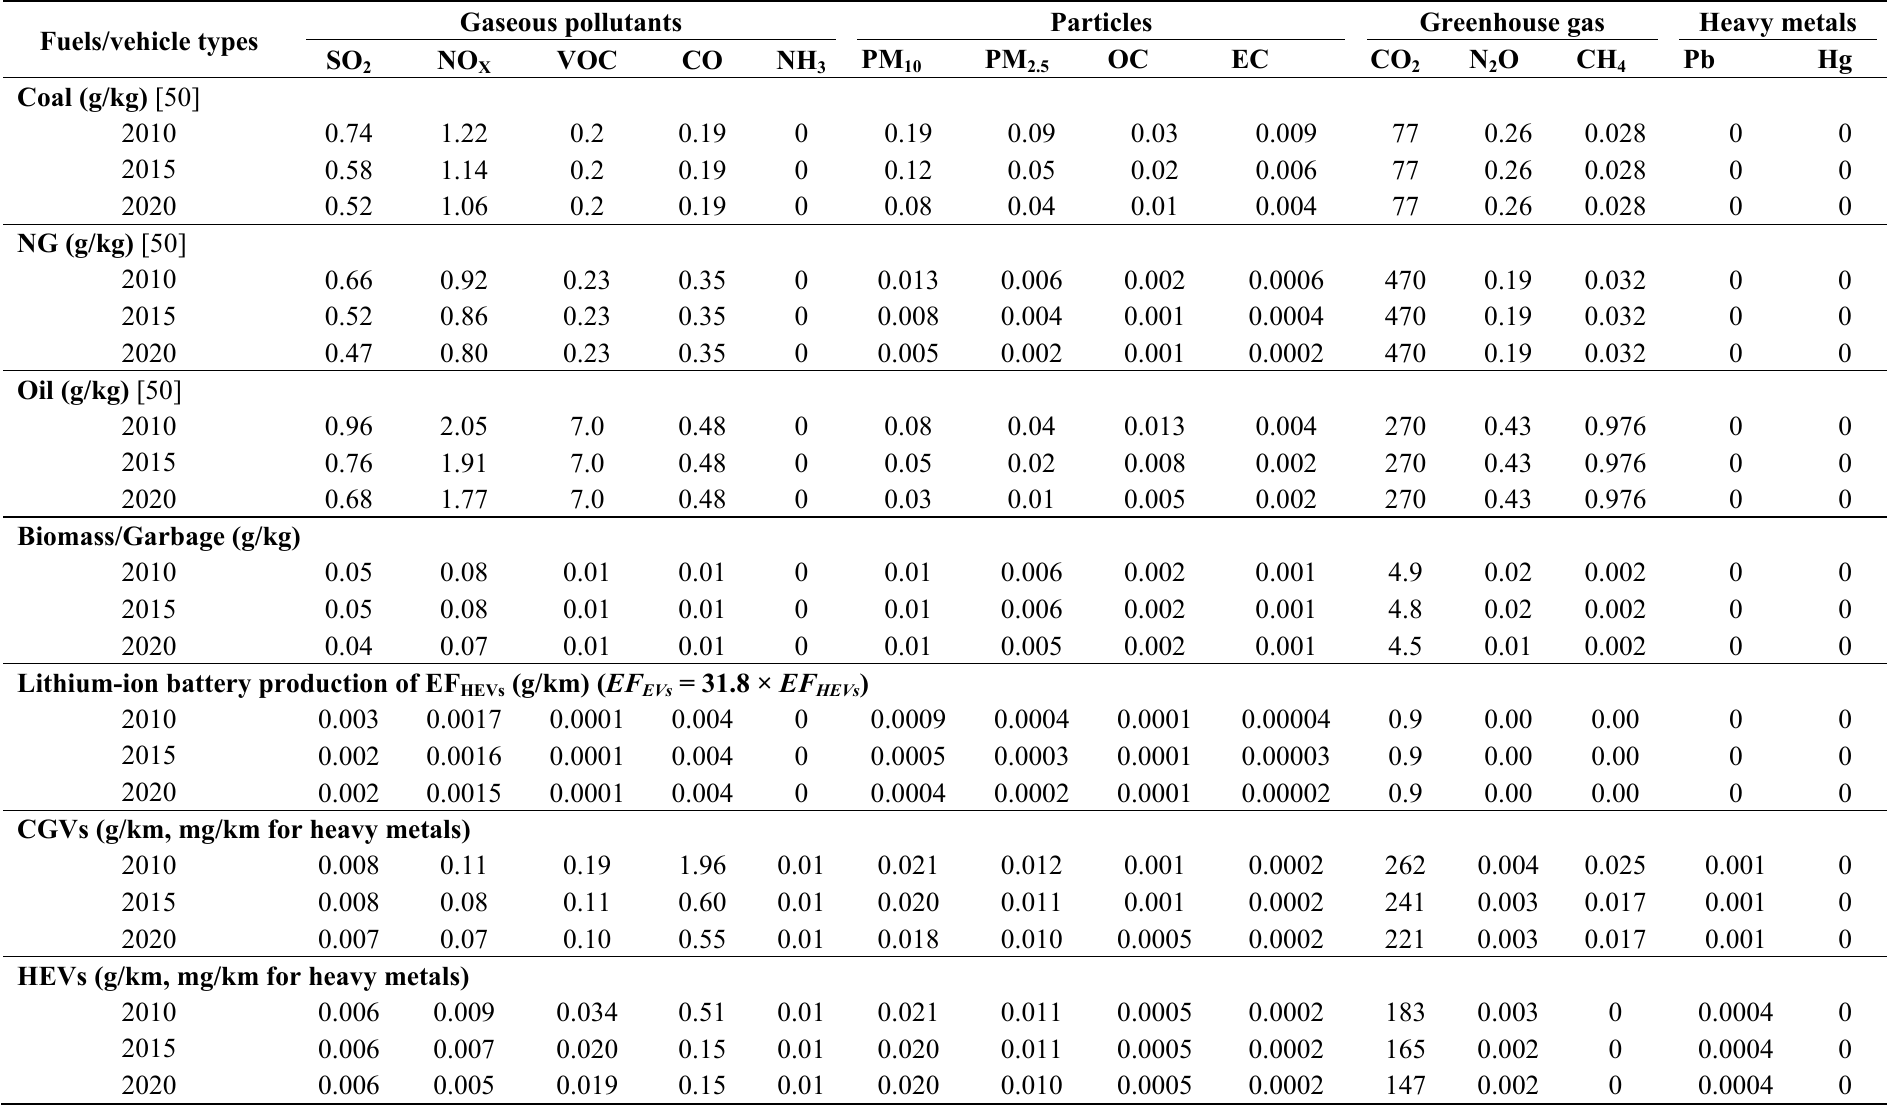
Table 8. Emission factors (EFs) of CGVs and HEVs’ driving stage and fuels’ production and transportation